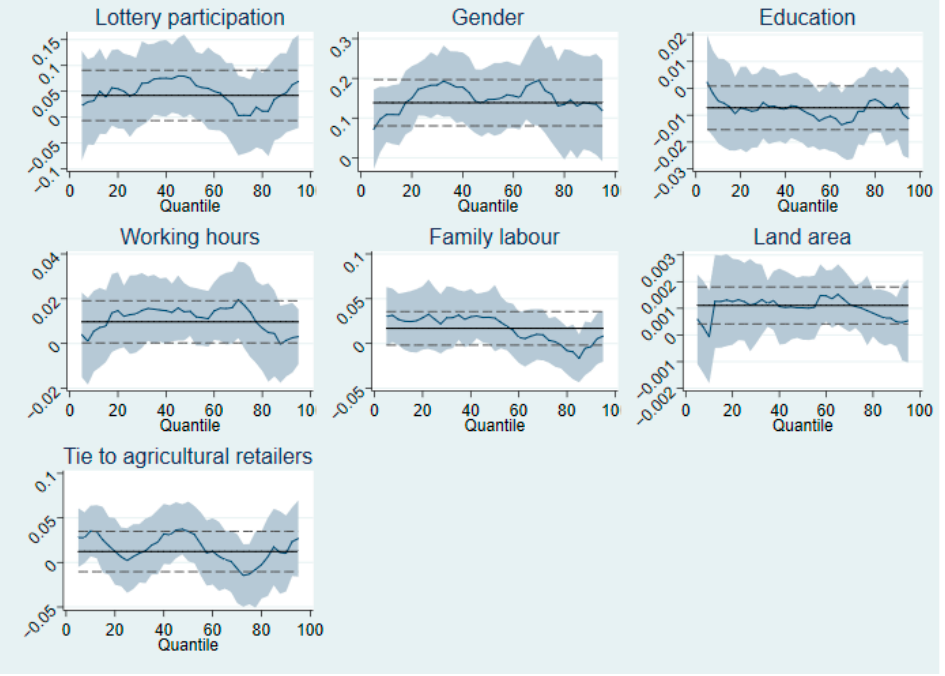
Figure 2. The impacts of factors on technical efficiency under different quantiles. Note: Shaded areas represent 95 percent confidence band for the quantile regression estimates. The black solid lines denote the conventional 95 percent con fi dence intervals for the OLS coe ffi cient.